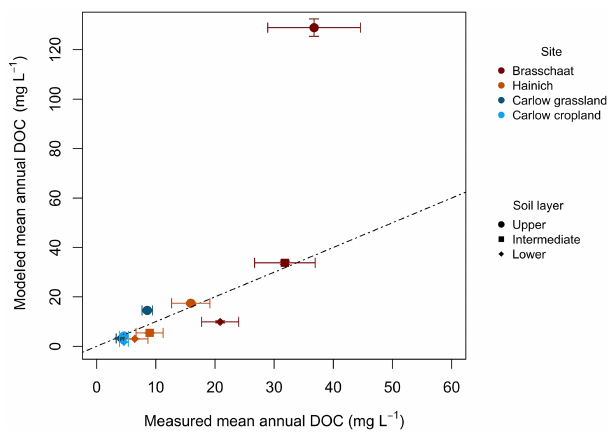
Figure 8. Measured vs. modeled mean annual DOC concentrations (mgCL − 1 ). Error bars represent the standard deviations for the mean annual DOC concentrations. The dashed line represents the 1 : 1